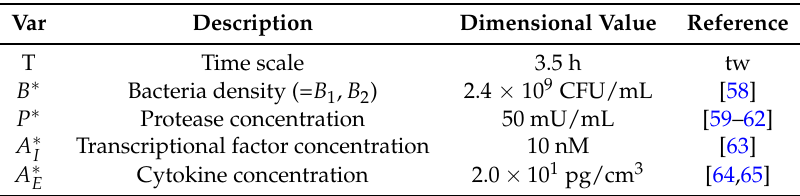
Figure B1 shows sensitivity analysis of all variables for ten key